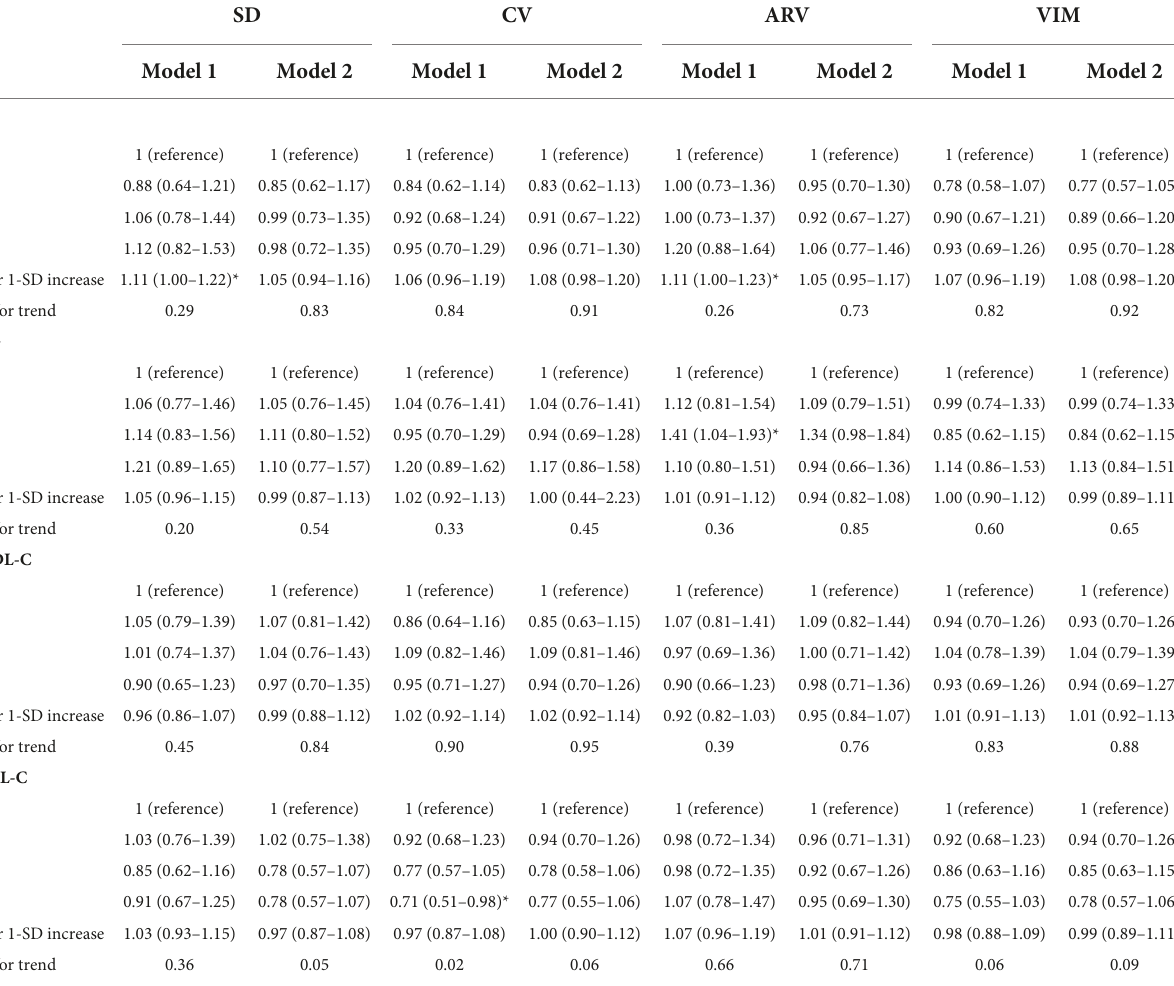
Model1:Age,sex,smoking,lipid-loweringdrugs,anti-hypertensivedrugs,familyhistoryofCVD,diabetes,andtheaveragevaluesofBMIandSBP. Model2:Model1+averagelipidlevelsforeachlipidparameter(TC,TG,HDL-C,LDL-C). HR, hazard ratio; CI, confidence interval; CVD, cardiovascular disease; TC, total cholesterol; TG, triglycerides; HDL-C, high-density lipoprotein cholesterol; LDL-C, low-density lipoprotein cholesterol; BMI, body mass index; SBP, systolic blood pressure; SD, standard deviation; CV, coefficient of variation; ARV, average real variability; VIM, variability independentofmean. P